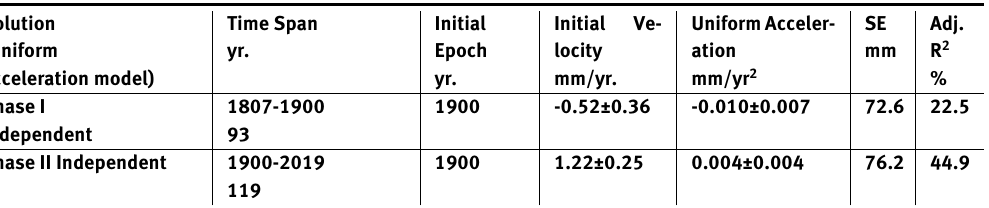
Table 4. OLS solution statistics using uniform acceleration model. Trend and velocity estimates in bold are statistically significant at α = 0.05. Phase I parameters were estimated using year 1807 and 1900 to check the robustness of the LP components. Note that the ini- tial velocity is dependent on the inial epoch but the uniform acceleration is invariant with repect to the choice of the initial epoch. Initial velocity estimate in bold is statistically